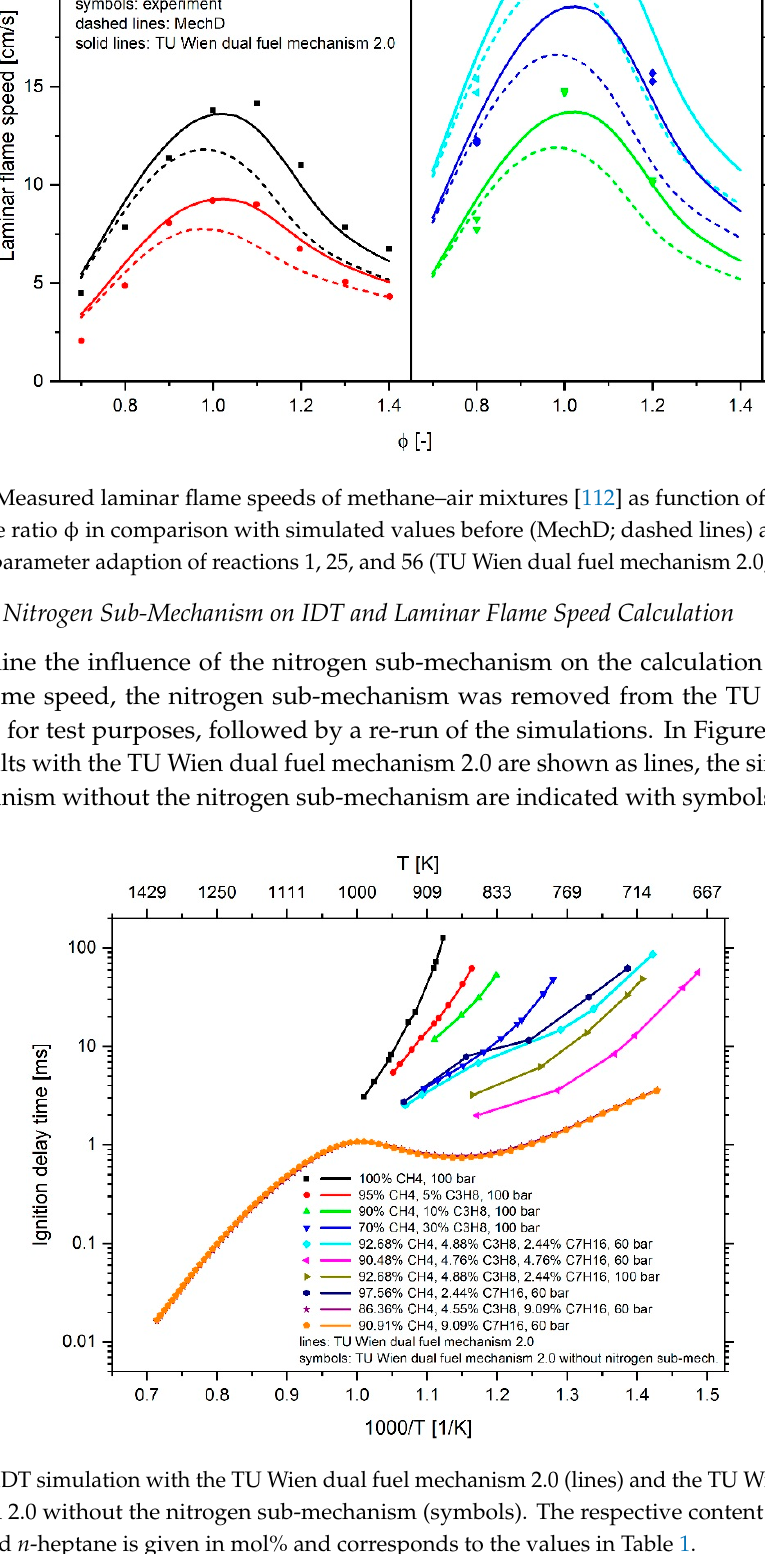
Figure 25. Simulated laminar flame speed values as function of the fuel – air equivalence ratio φ using the TU Wien dual fuel mechanism 2.0 (lines) and the TU Wien dual fuel mechanism 2.0 without the nitrogen sub-mechanism (symbols). The comparison shows that the nitrogen sub-mechanism has a negligible influence on the calculation of the IDT in the parameter range under consideration. The same applies to the calculation of the laminar flame speed, where no differences can be seen when the nitrogen sub-mechanism is taken into account or neglected. It can be stated that by the modification of the TU Wien mechanism for dual fuel combustion presented in [7], the mechanism TU Wien dual fuel mechanism 2.0 was developed, which can reproduce the IDT of the investigated homogeneous methane, methane – propane, methane – n -heptane, and methane – propane – n -heptane mixtures in the pressure range 60 to 100 bar well and